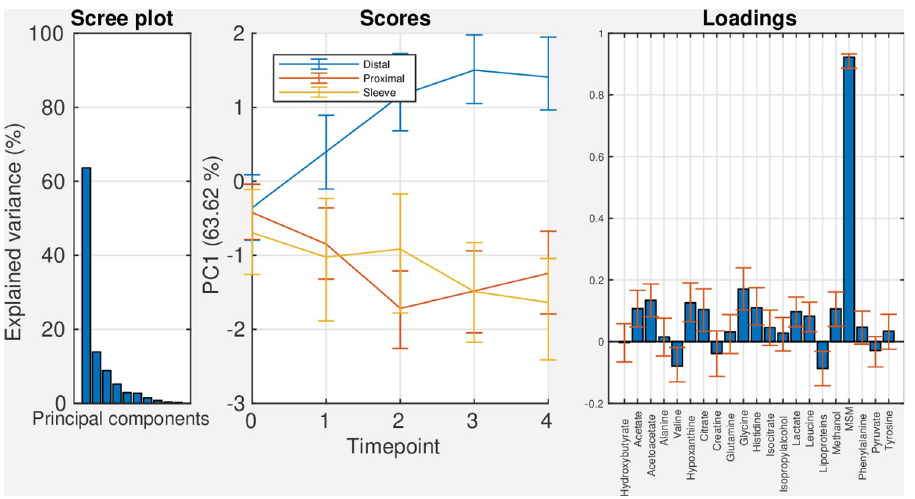
Fig 4. Scree-, score-, and loading plots for the effect matrix for the treatment + time � treatment interaction effect. Abbreviations: PC: principal component, MSM: methylsulfonylmethane.